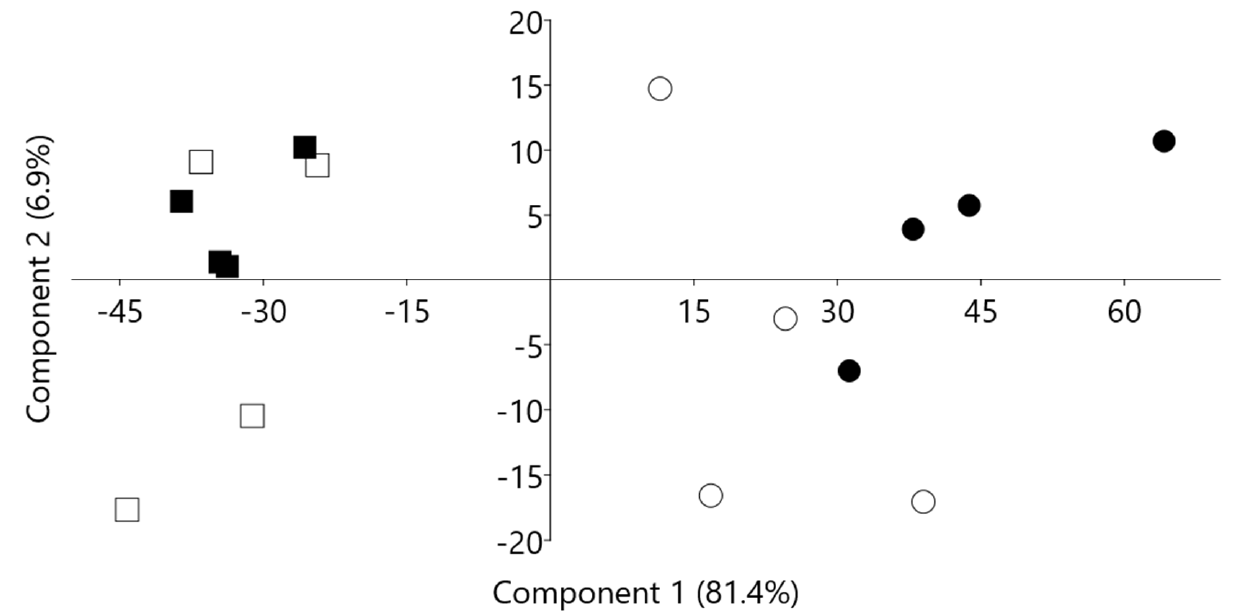
Figure 3. Principal components plot derived from the analysis of rumen fermentation, fatty acid biohydrogenation, and microbial community profile data, showing the discrimination along prin- cipal components 1 and 2 of RUSITEC fermenters receiving either a high forage (squares) or a high concentrate (circles) under a higher pH (filled symbols) or a lower pH (hollow symbols) in the fer- menter.